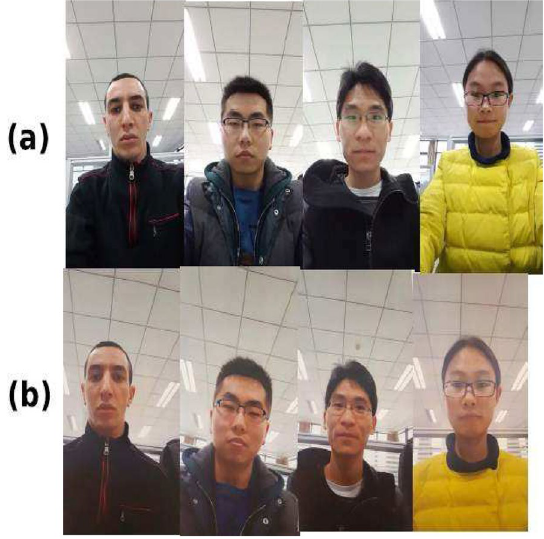
Fig. 15 Examples (both natural and spoof-print versions) from the original OULU-NPU dataset